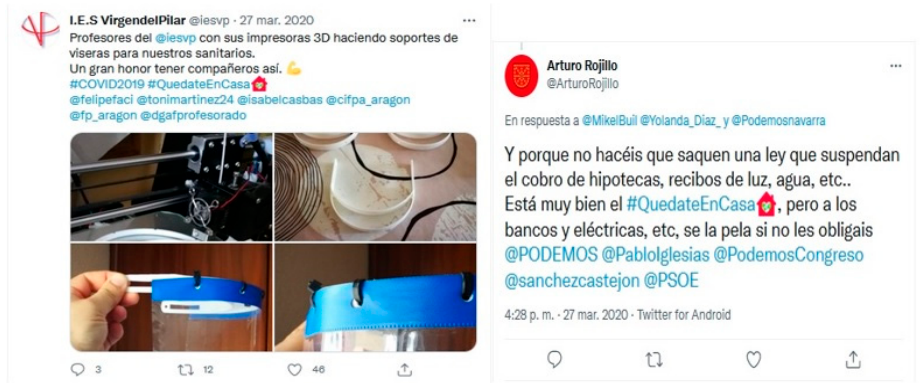
Figure 8. Example of sample content 2.